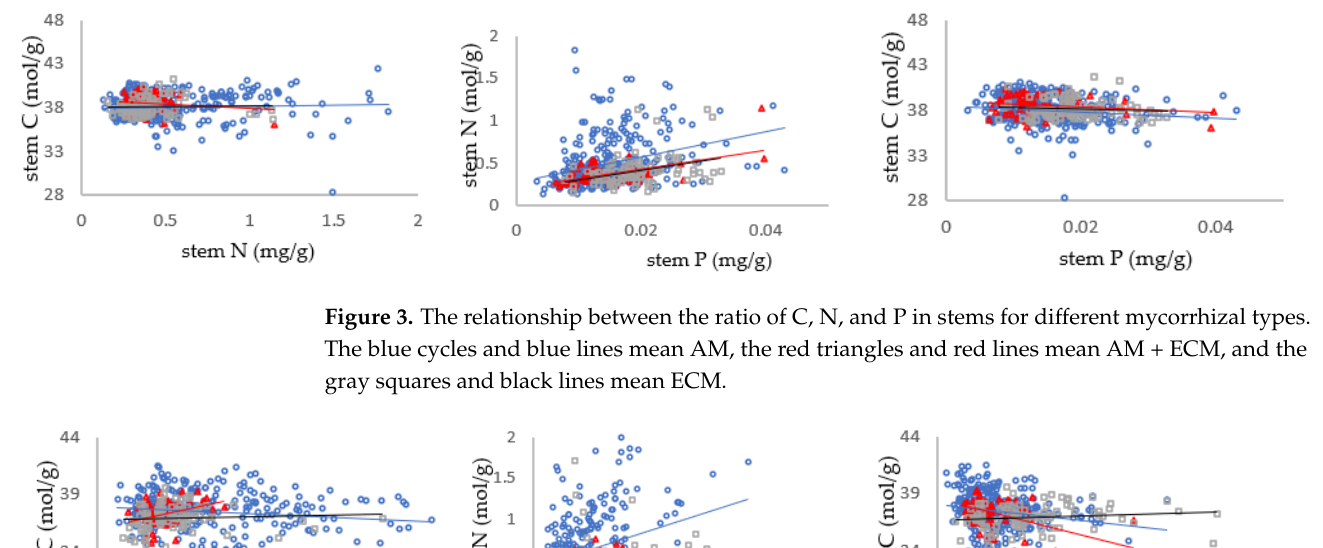
Figure 3. The relationship between the ratio of C, N, and P in stems for different mycorrhizal types. The blue cycles and blue lines mean AM, the red triangles and red lines mean AM + ECM, and the gray squares and black lines mean ECM.